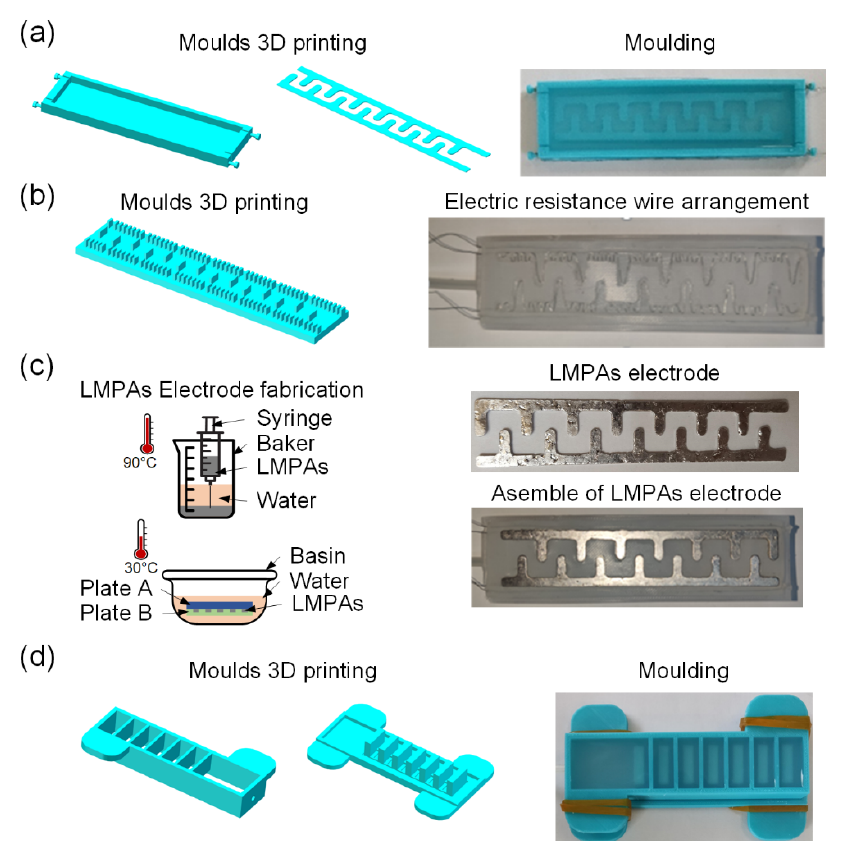
Figure 2. The fabrication procedure of the VSEAF: ( a ) comb groove modeling, ( b ) arrangement of the electric resistance wire, ( c ) fabrication of comb structure low-melting-point alloys, and ( d ) fabrication of a soft pneumatic gripper.